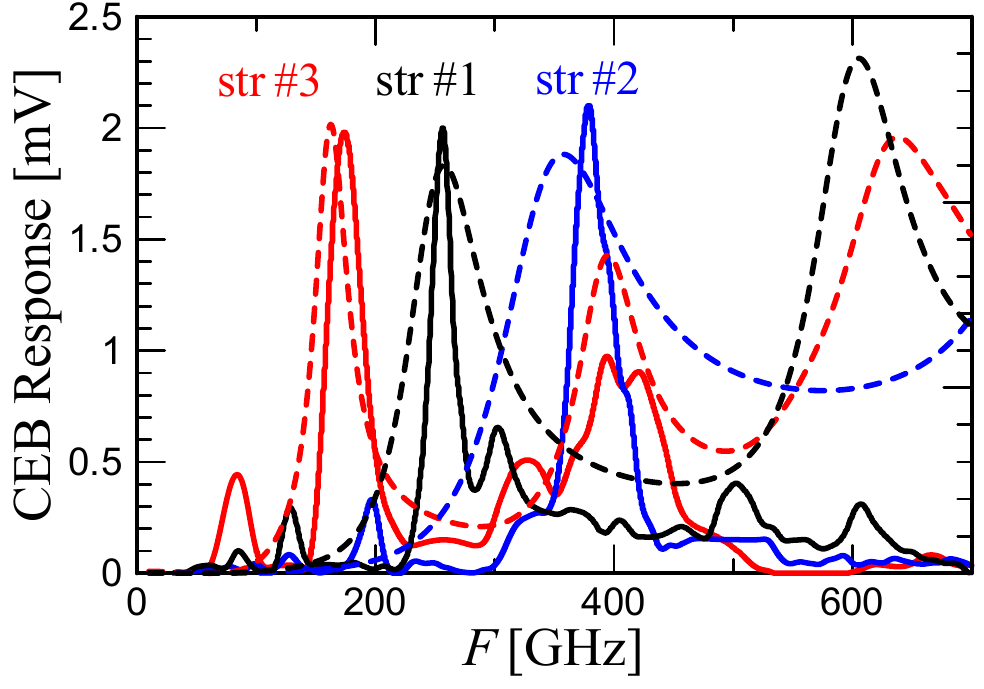
Figure 3. Amplitude-frequency response of a broadband bolometer to the radiation of three JJ generators. Solid curves—measurements, dotted curves—electro-magnetic modeling of JJ antennas. Structure notations correspond to Figure